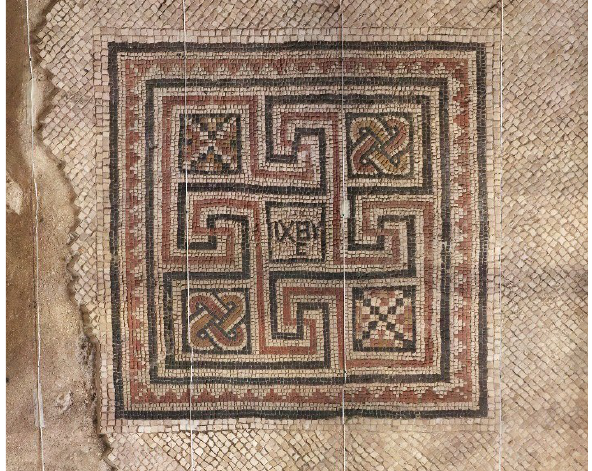
Figure 15. Ortho-image of mosaic C obtained from SfM methodology